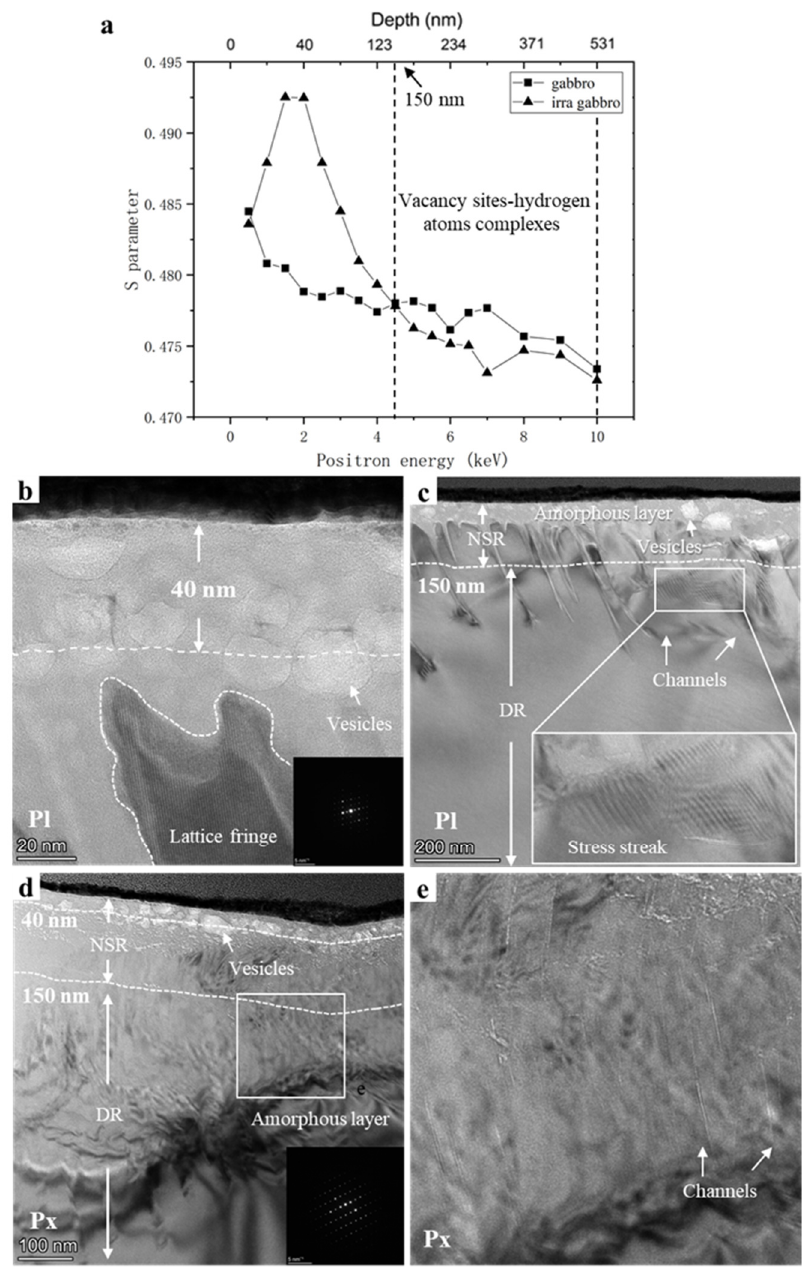
Figure 4. ( a ) S – E curves of gabbro and irradiated gabbro. The white dashed lines indicate the vacancy sites—hydrogen atom complex region. ( b ) TEM bright-field and ( c ) HRTEM images of plagioclase. The SAED pattern of plagioclase is shown in the insert in the bottom right corner of ( b ). The white dashed line represents the current depth. ( d ) TEM bright-field and HRTEM images of pyroxene. ( e ) HRTEM images of the channel effect in Figure d. The SAED pattern of plagioclase is shown in the insert in the bottom right corner of ( d ). The white dashed line represents the current depth. NSR, near-surface region; DR, deeper region.